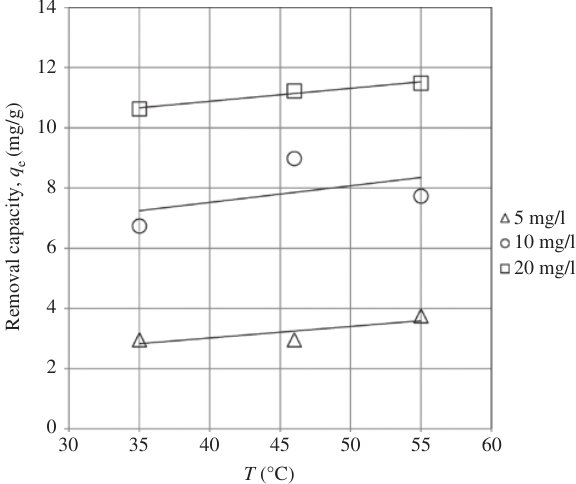
Figure 7: Effect of temperature on methylene blue removal by basic- treated human hair adsorbent.